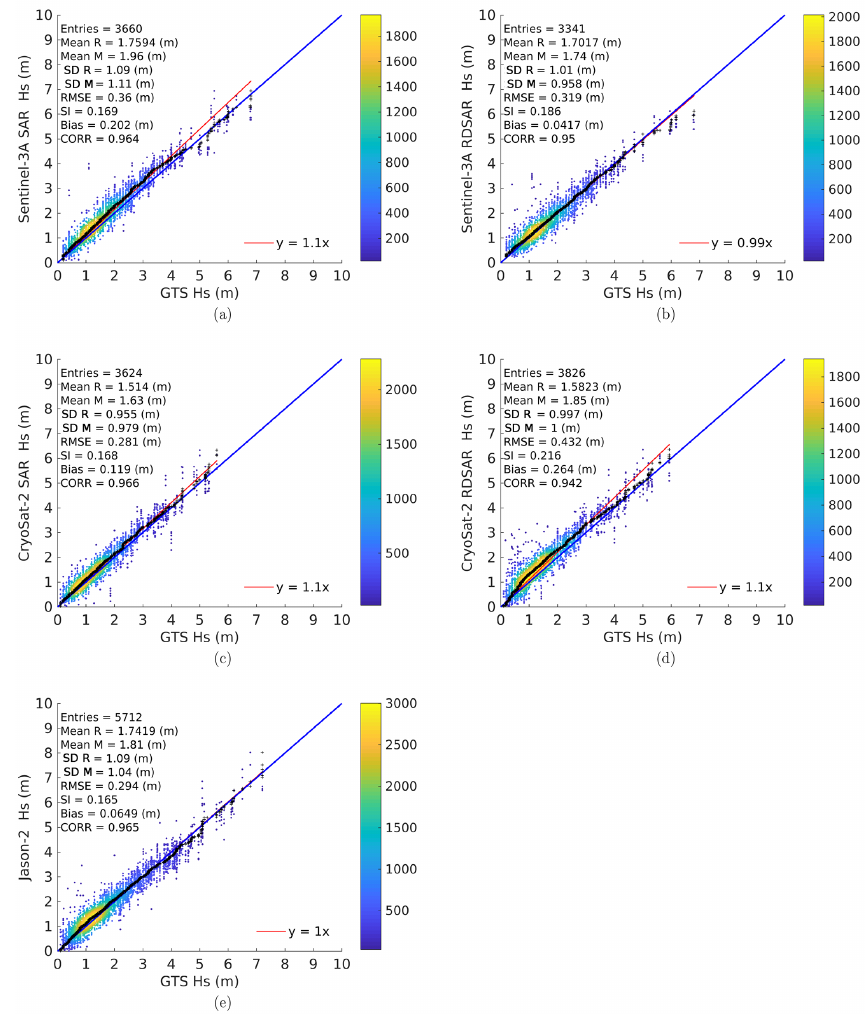
Figure 7. Q–Q scatter plots of measured significant wave height – in situ GTS (R) versus remote sensing data (M) of (a) Sentinel-3A SAR, (b) Sentinel-3A RDSAR, (c) CryoSat-2 SAR, (d) CryoSat-2 RDSAR and (e) Jason-2 from June to November 2016: Q–Q plot (black crosses), 45 ◦ reference line (blue line) and least-squares best-fit line (red line).